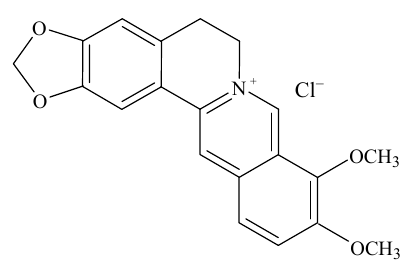
Figure 2. Structure of